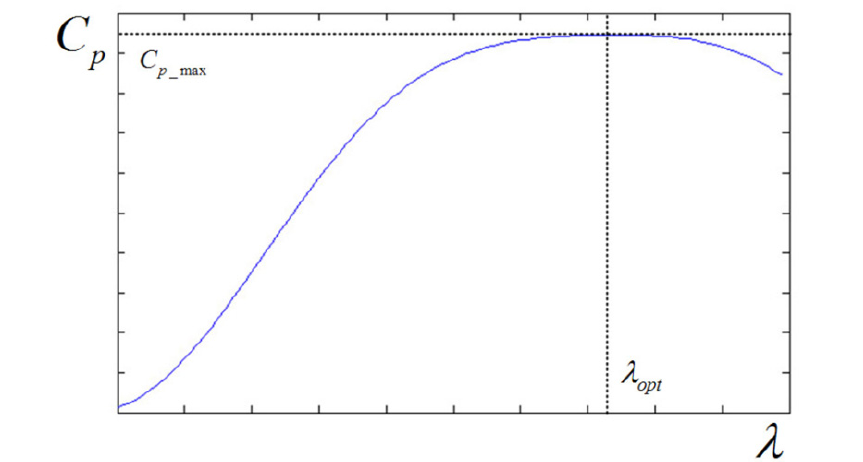
Figure 5. Power coefficient